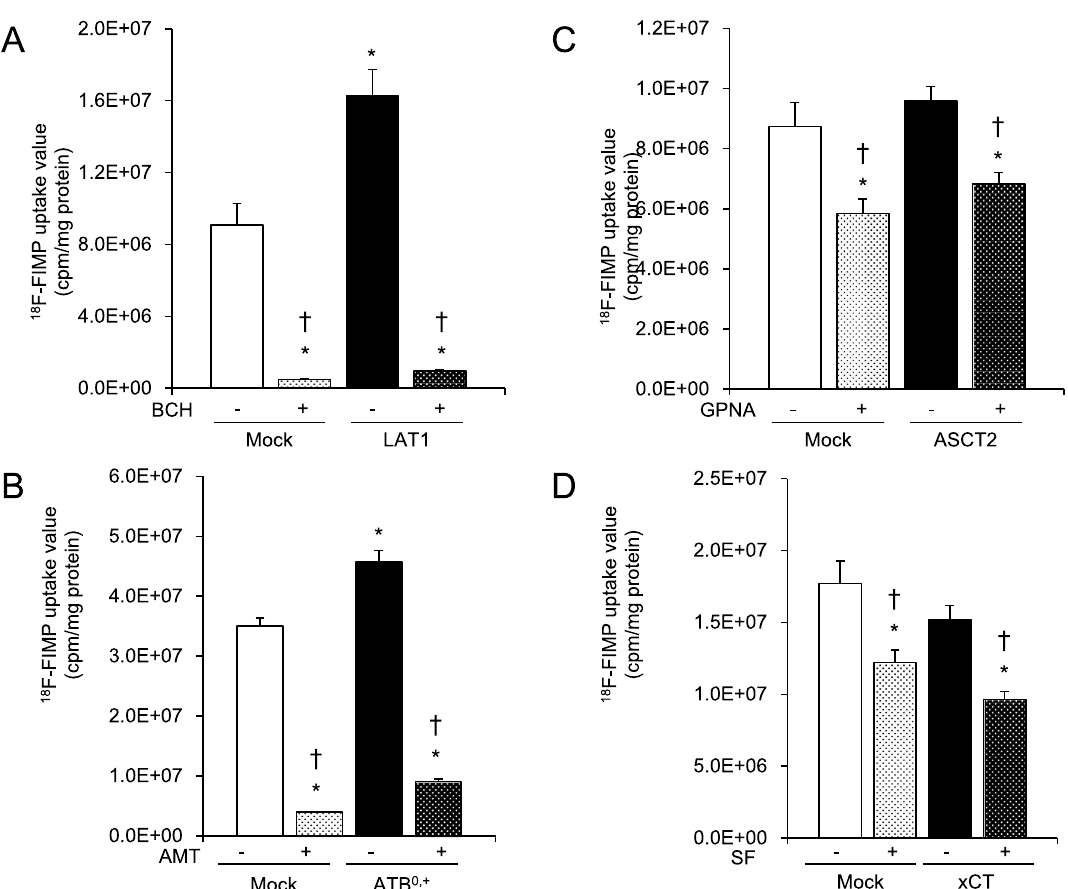
Fig. 5 Functional analysis of amino acid transporter-overexpressing cell lines. Transporter-mediated 18 F-FIMP uptake was measured in the presence ( ) or absence ( ) of specific inhibitors (BCH, AMT, GPNA, or SF) in control vector-transfected cells (Mock) and expression vector-transfected + − cells. Data are presented as the mean SD (n 4–6). * P < 0.01 when compared to mock cells without an inhibitor; † P < 0.01 when compared to ± = the corresponding overexpressing cells without an inhibitor. AMT, α-Me-DL-Trp; BCH, 2-aminobicyclo-(2,2,1)-heptane-2-carboxylic acid; GPNA, L-γ-glutamyl-p-nitroanilide; SF,